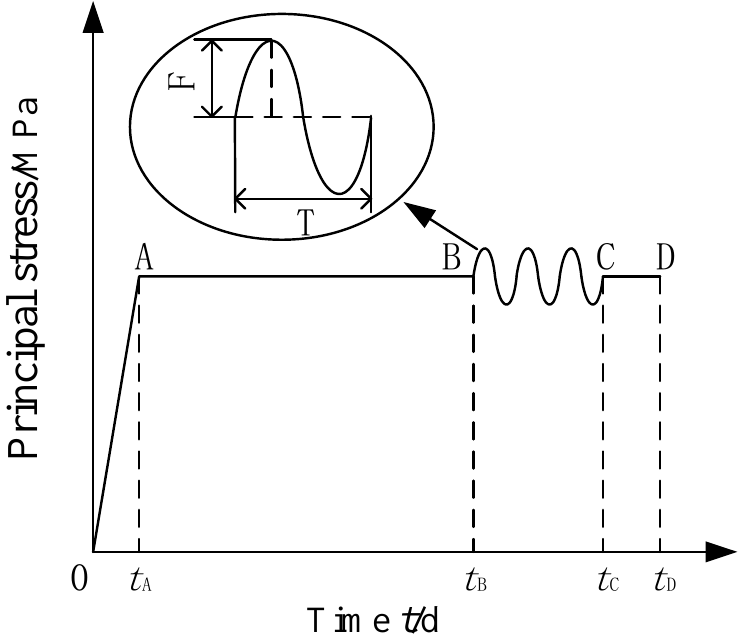
Figure 2. Soft rock rheometer.